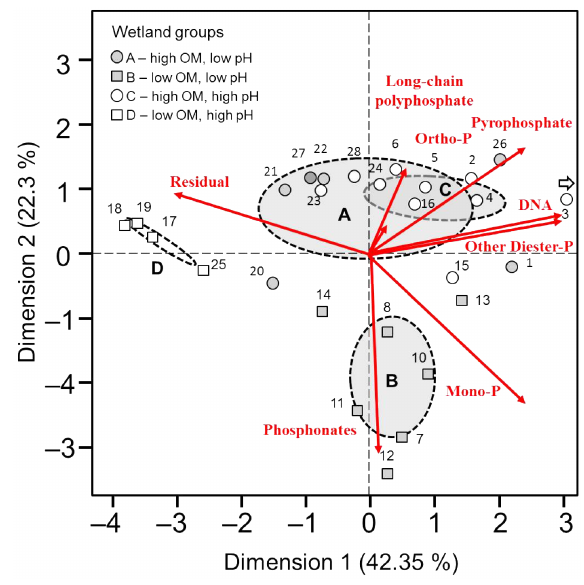
Figure 4. Biplot of the scaled first two principal components of phosphorus composition in wetland soils. Ellipses represent 95% confidence interval surrounding barycenter of four wetland group- ings based upon pH and organic matter content. Proportional load- ing of P composition superimposed in